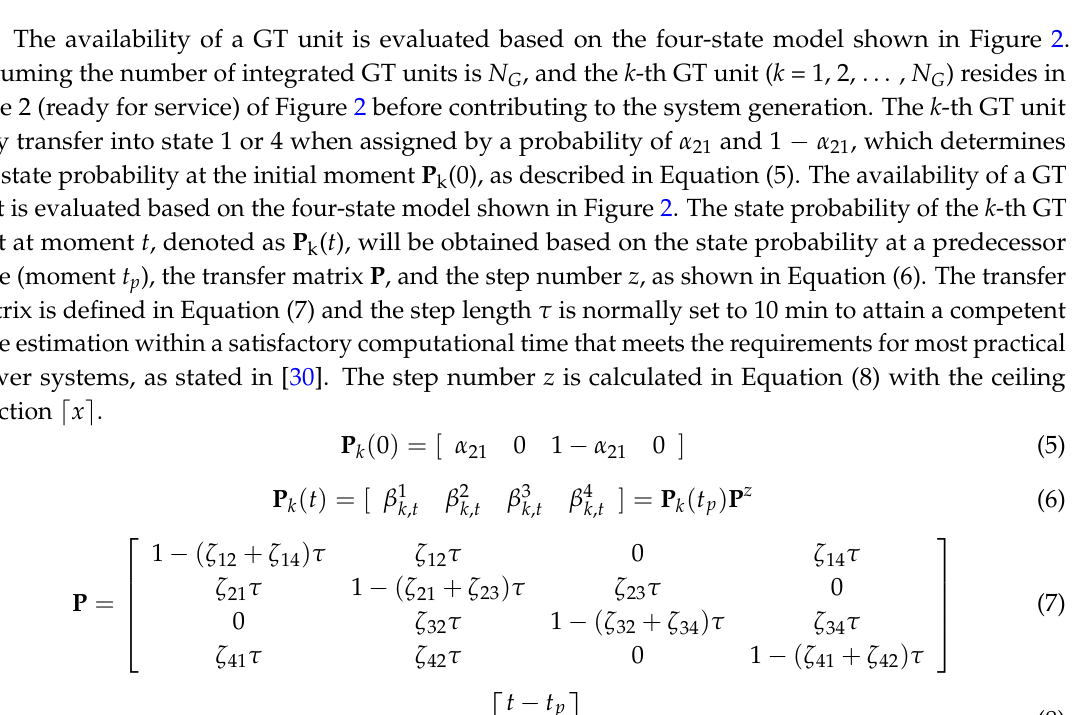
Figure 2. Four-state model of rapid start units.